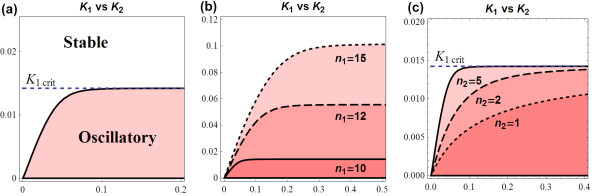
(a) K1 vs. K2 bifurcation diagram at n1 = 10, n2 = 5 (using k1 = 1, k2 = 2, k3 = 1, kd1 = 1.2, kd2 = 3, kd3 = 2); (b) Bifurcation diagram for increasing n1 at n2 = 5; (c) Bifurcation diagram for increasing n2 at n1 = 10.